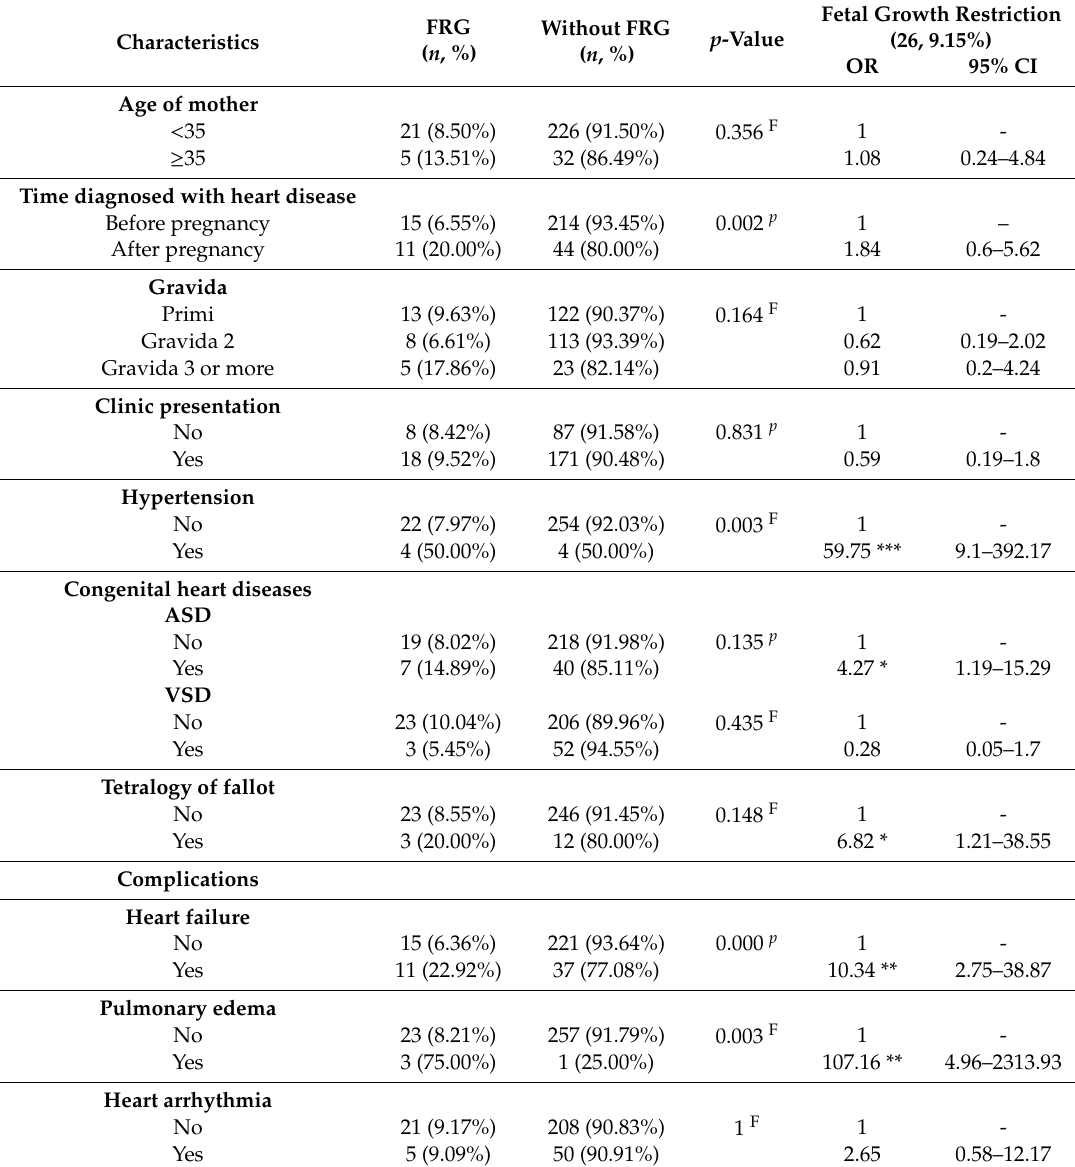
Table 5. Related factors of fetal growth restriction among pregnant mothers with heart disease: Multivariate logistic progressions ( n =